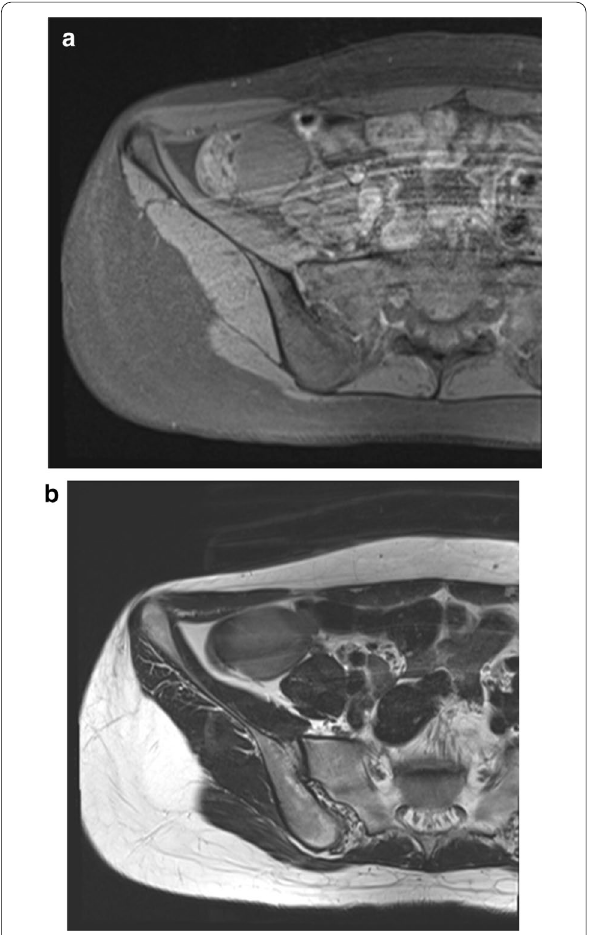
43-mm mass attached to ×